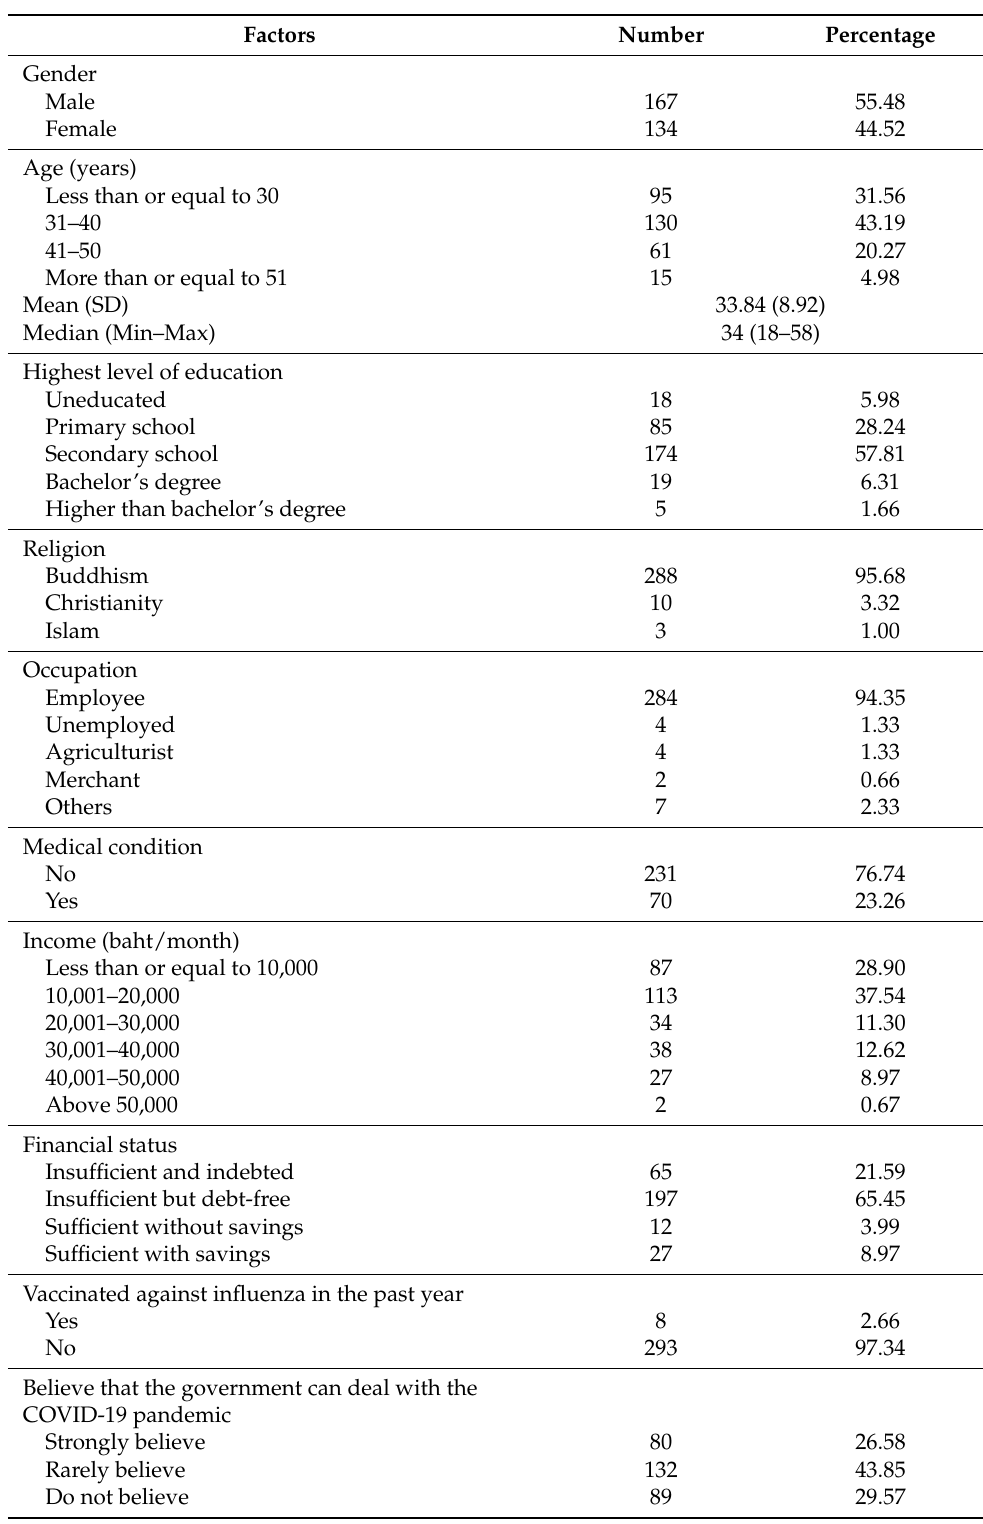
Table 1. Socio-demographic factors of Myanmar migrant workers ( n =